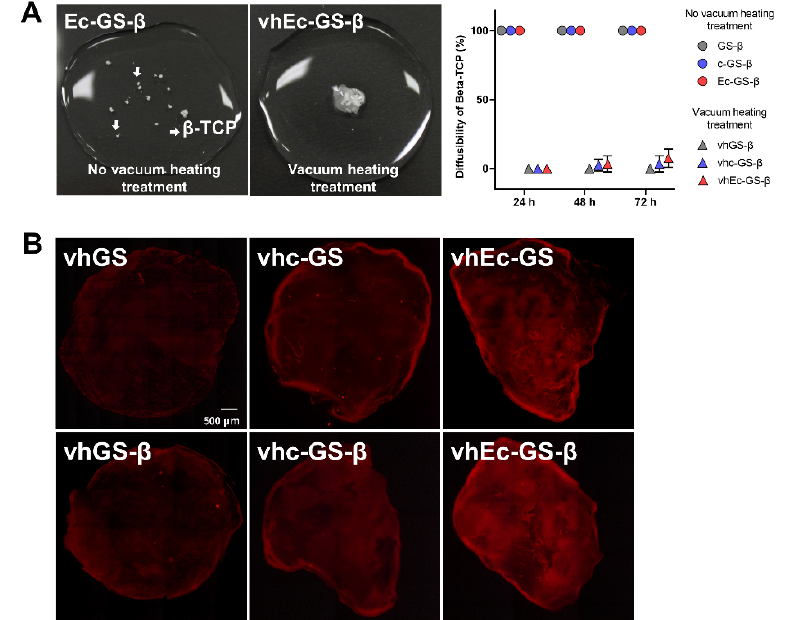
Figure 3. β -TCP leakage and microscopic images of hydrogels. ( A ) Representative macroscopic images of hydrogels and quantitative data after their immersion in water. Arrows: leaked β -TCP granules. ( B ) Microscopic images of hydrogels after gelatin staining.